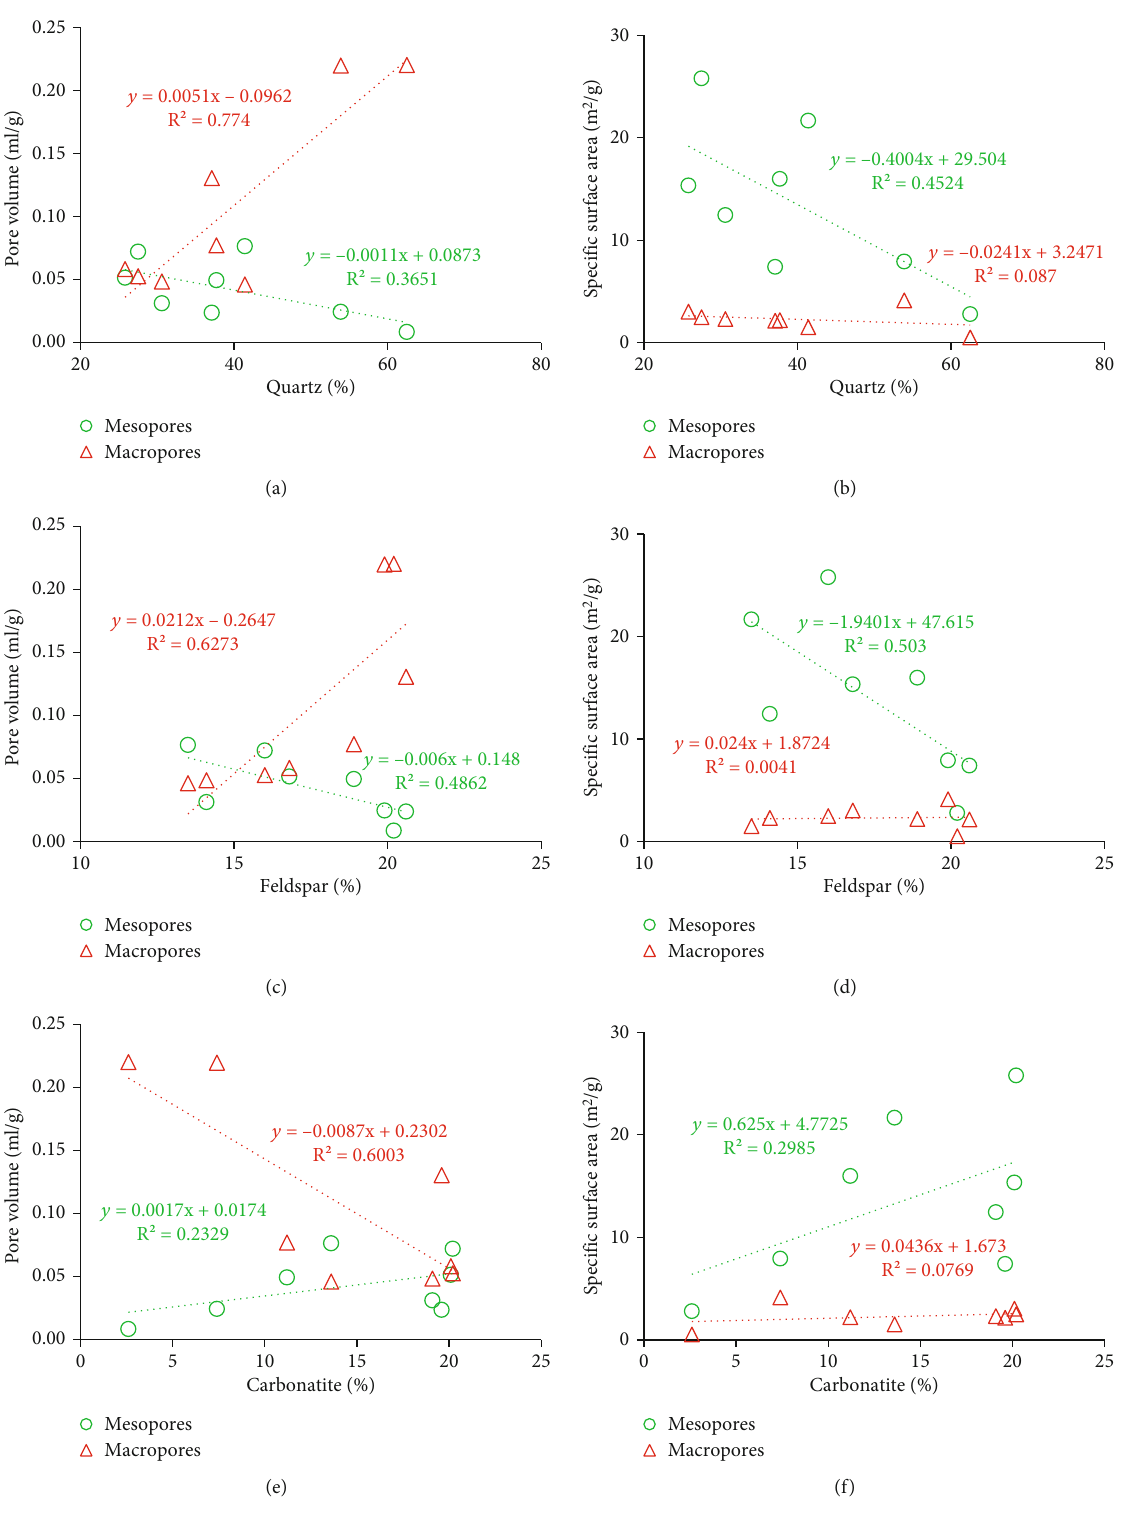
Figure 13: Plots showing the relationship between pore structure and rigid mineral content. (a, c) Macropore pore volume is positively correlated with quartz and feldspar; (b, d) mesopore speci fi c surface area is negatively correlated with quartz and feldspar; (e) macropore pore volume is negatively correlated with carbonate; (f) mesopore speci fi c surface area has a weak positive correlation with